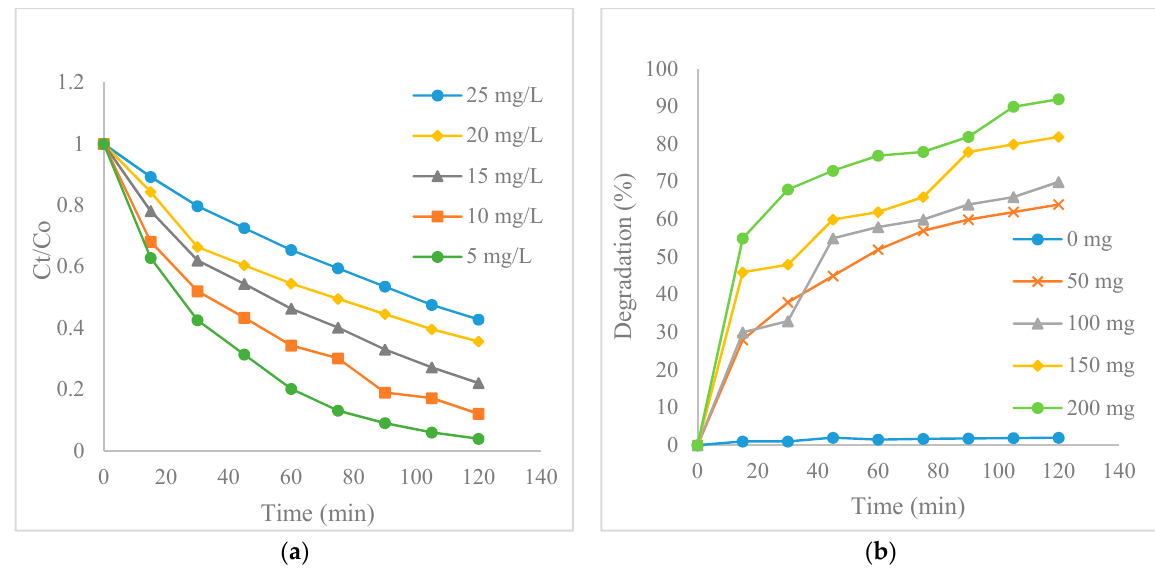
Figure 8. ( a ) Effect of initial dye concentration, and ( b ) Effect of catalysts loading on the photo degradation of MO (MO initial concentration: 10 mg/L, pH value (pH = 7)).